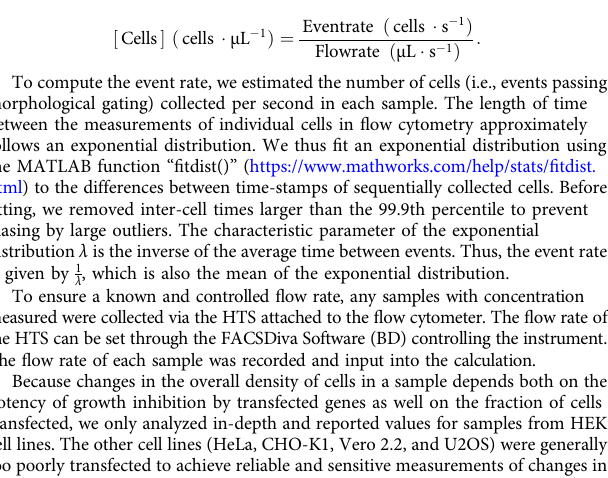
Fig. 44a. This step reduced the correlation between the nominal output levels of {P}:output 1 and the fold changes in response to resource loading by Gal4